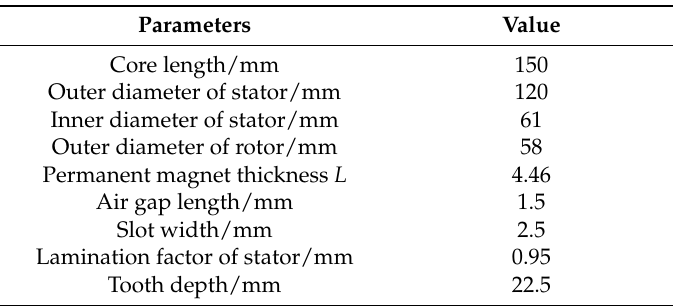
Table 1. The structural parameters of the DRPMSM.